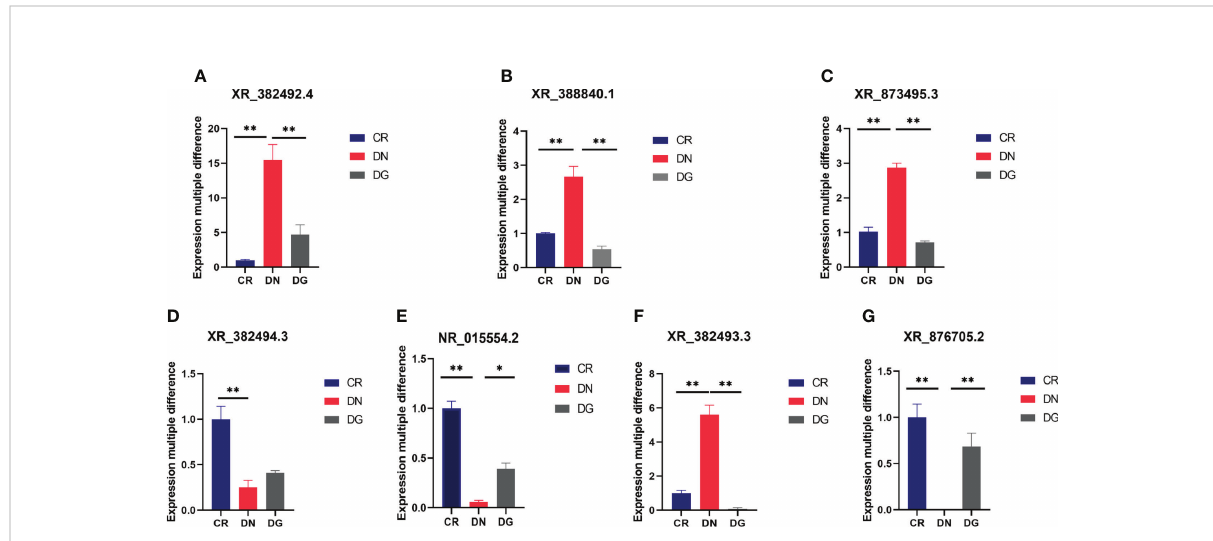
FIGURE 8 (A – G) Validation of key LncRNAs by qRT-PCR (n=6). Data are presented as the mean ± SE. *P < 0.05; **P < 0.001. CR, control group; DN, diabetic nephropathy group; DG, dapagli fl ozin